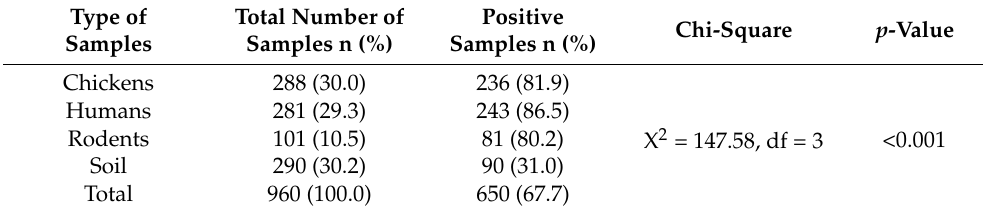
Table 1. Isolation frequencies of Escherichia coli from different